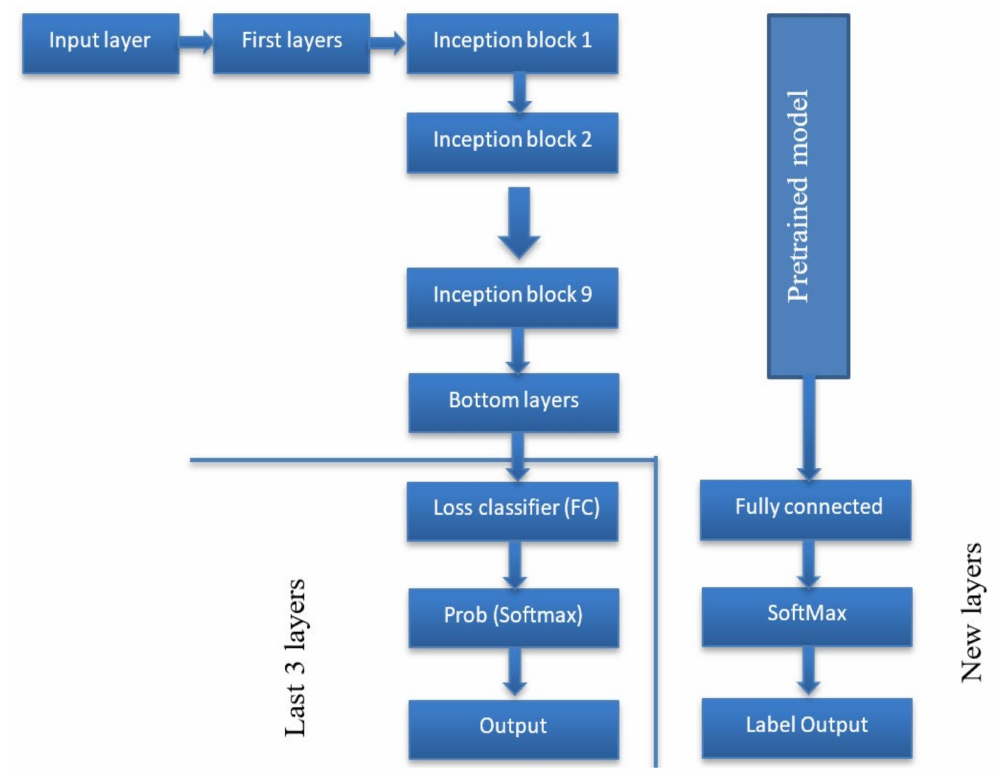
Figure 5. The architecture of the proposed